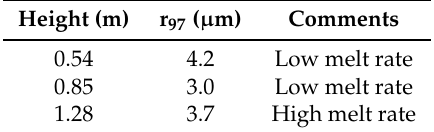
Table 2. Size of the largest inclusions (r 97 ) in the samples taken from the ingot near the